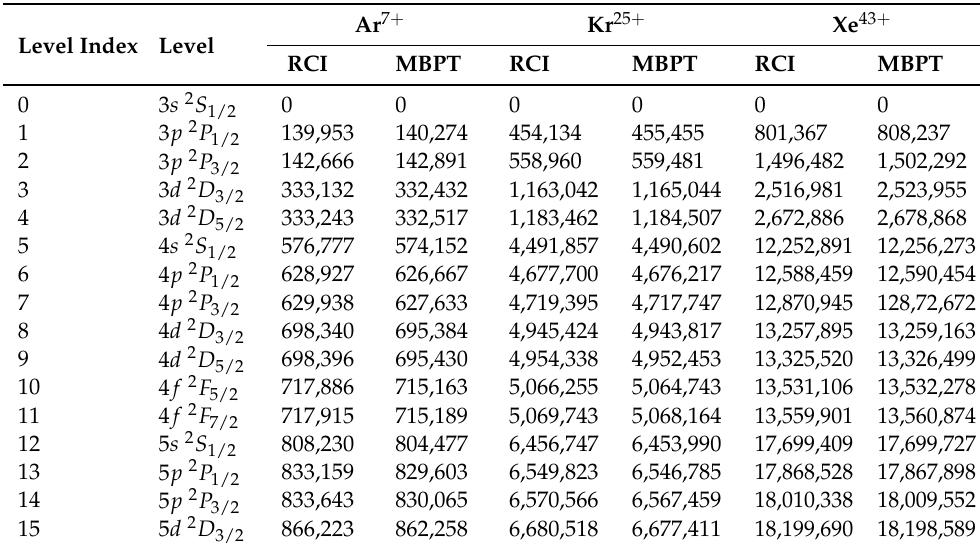
Table 3. The present RCI and MBPT energies (in cm − 1 ) for the lowest 71 levels of Ar 7 + , Kr 25 + and Xe 43 +